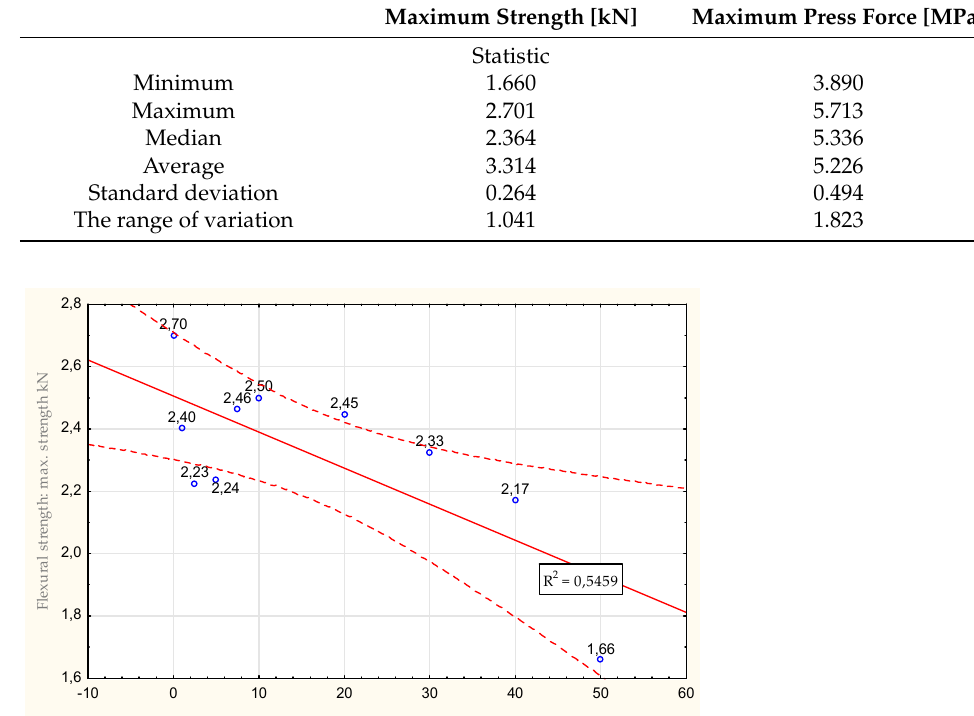
The compressive strength values of the cement slurries for all tested formulas were lower than those of the zero sample. The closest to the zero sample was the formula containing 5% dust in its composition, for which the values were about 1.5% lower. For the other samples, the compressive strength values were reduced in the range of 6–37% compared to the zero sample. Table 15. Flexural strength tests for basalt dust A for all samples for water − mix ratio = 0.7. Maximum Strength [kN]